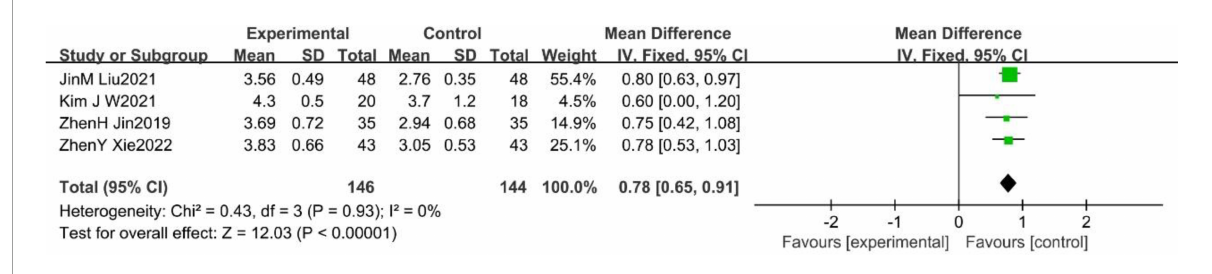
FIGURE7 Forest plot of the effects of WBV training on FAC.